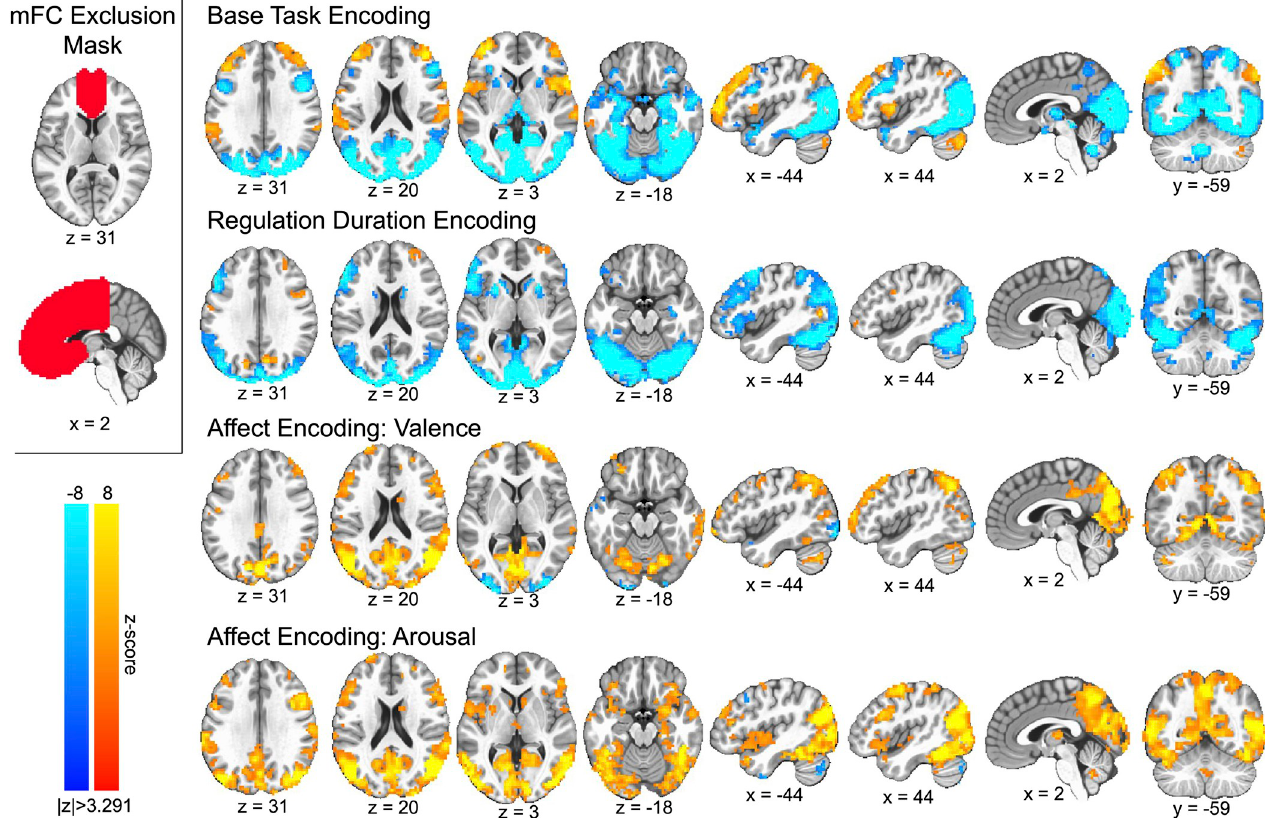
Fig 4. Group-level linear mixed-effect model distributions of the main fixed-effects of base task (i.e., model intercept), regulation duration, and affect processing for all gray matter voxels excluding the medial frontal cortex. The medial frontal cortex gray matter exclusion mask is displayed in the upper left. We report only the distributions for valence as they were highly similar to those for arousal (see OSF repository full maps). The figure depicts slices in MNI coordinate space and neurological convention (image left equals participant left). The figure depicts voxel intensities as colors having a minimum (thresholded) voxel intensity of |z| = 3.291 and a maximum absolute voxel intensity of |z| = 8.0, i.e., color saturates for z-scores above and below the maximum intensity. To correct for multiple comparisons (p < 0.05), the figure depicts only valence-derived clusters having � 14.9 contiguous voxels (measured as face wise nearest neighbors, i.e., NN = 1) or arousal-derived clusters having � 16.5 contiguous